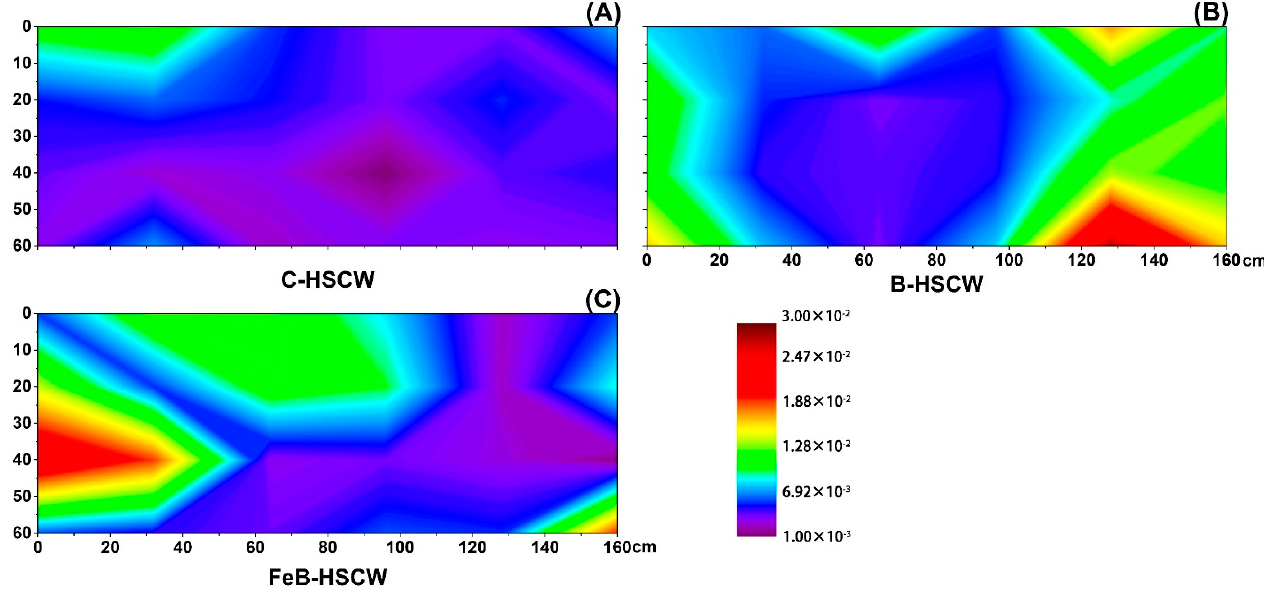
Figure 6. The spatial distribution of nirS relative abundance in C-HSCW ( A ), B-HSCW ( B ), and FeB-HSCW ( C ) based on interpolated maps. Color scales indicate extrapolated values by kriging. C-HSCW, without biochar and FeB-modified biochar; B-HSCW, with biochar; FeB-HSCW, with FeB-modified biochar.